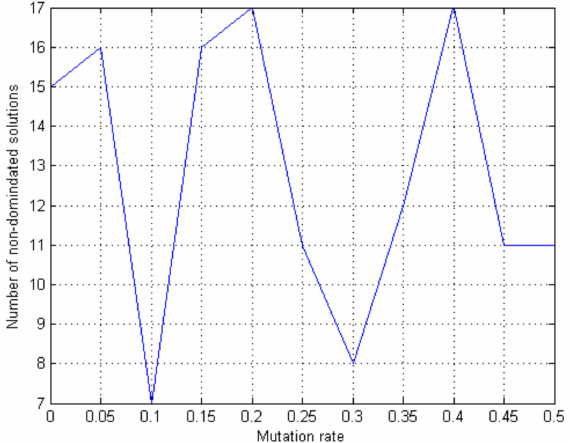
Figure 4. Number of nondominated solutions vs. mutation rate.